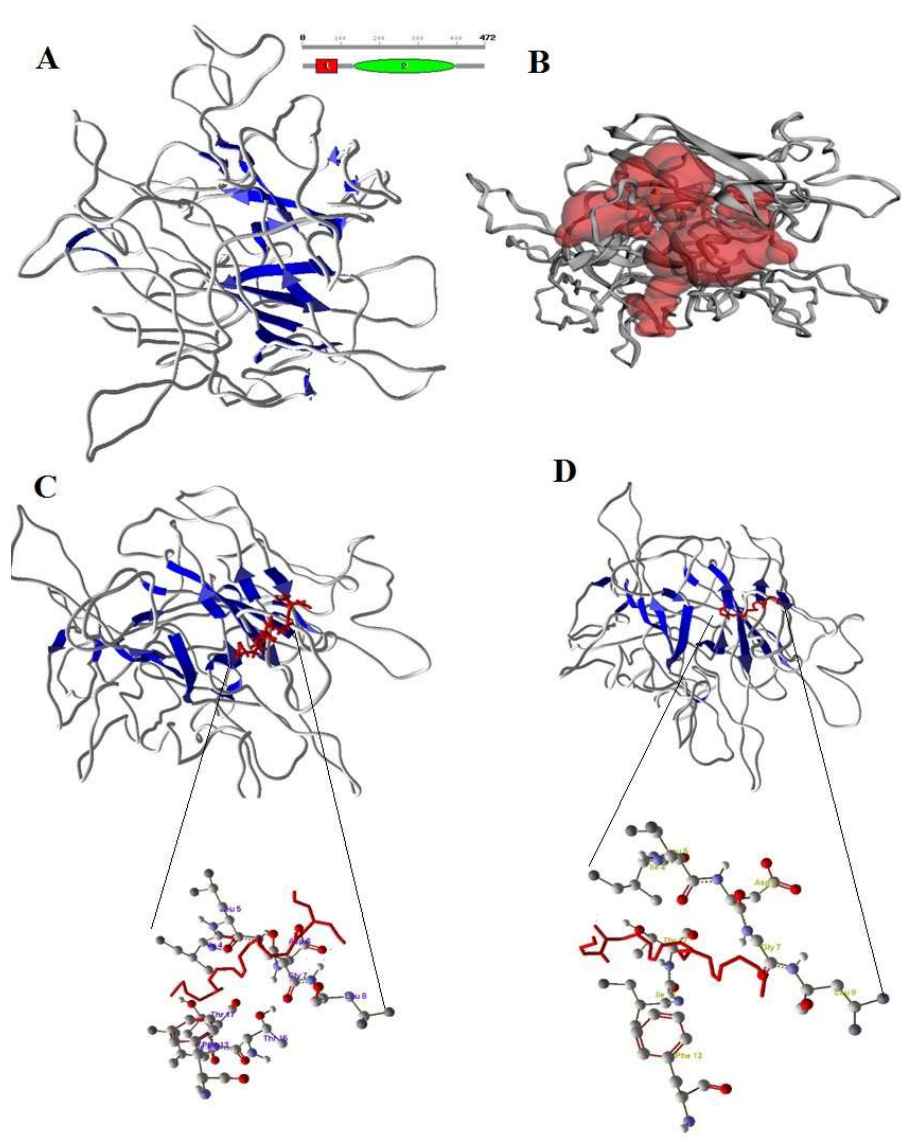
Figure 3. ( A ) Structure of CB1 with sheets (blue color). ( B ) Active site of CB1 in red color pocket in the structure. ( C ) Docking of 2-AG (red color) and Amino acids of CB1 involved in docking with 2-AG. ( D ) Docking of AEA (red color) with CB1 and Amino acids of CB1 involved in docking with AEA.